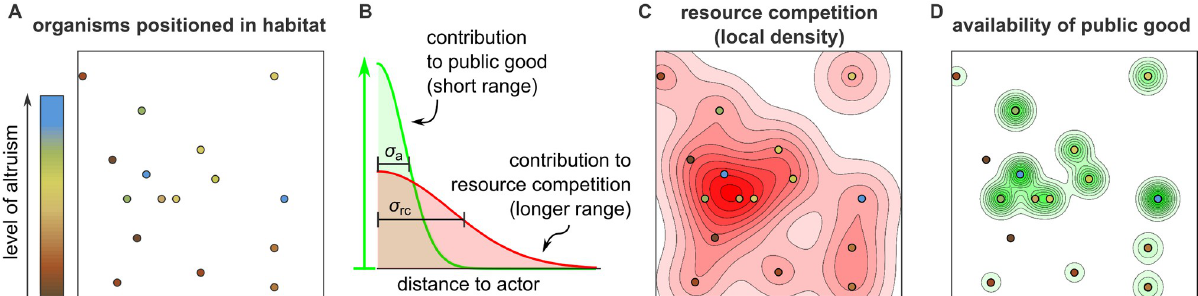
Fig 1. Illustration of the model. (A) The model considers a population of individuals, here represented as circles, in an explicitly spatial habitat. Individuals reproduce, die, and move stochastically, and are characterized by their level of altruism, indicated in color. Altruism is costly to the actor, but beneficial to recipients: it increases their reproduction rate. (B) For concreteness, imagine that each altruist produces a public good and secretes it locally. The contribution of a particular altruist to the concentration of public good falls with the distance (green curve) and increases with the level of altruism of the actor (vertical arrow). At the same time, individuals compete for a limiting resource: the reproduction rate of each individual is inhibited by each individual in its neighborhood (red curve). The scale of altruism σ a and the scale of resource competition σ rc are indicated. (C & D) The competition experienced at any coordinate (panel C, red contour plot) and the availability of public good at any position (panel D, green contour plot) are obtained by summing up the contributions of all individuals.